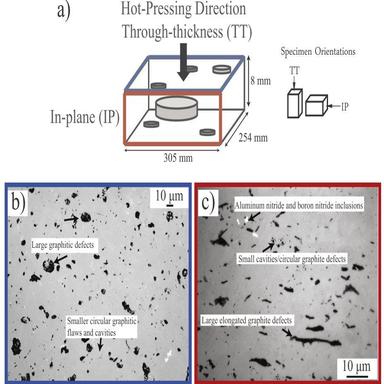
(a) Conceptualized as-received tile of the hot-pressed boron carbide plate with through-thickness (TT) (in the hot-pressing direction) and inplane directions (IP) labeled. Optical microscope images of the boron carbide microstructure in the (b) through-thickness (at 10× magnification) and (c) in-plane direction (100× magnification) with the various types of inclusions and defects. .